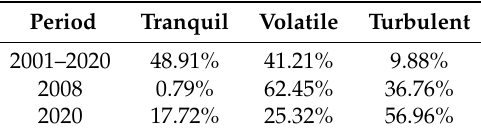
Table 2. Percentage of time spent by the S&P 500 index in each regime: ratio between number of days in regime i and number of days in the whole